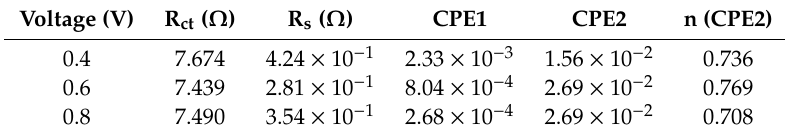
Table 6. Parameters derived from impedance spectra of P-5PA at di ff erent voltages.